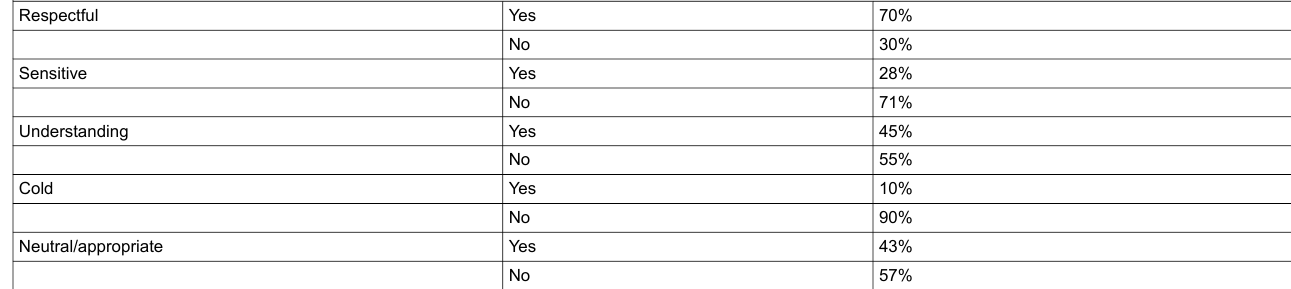
Table 5: Respondents’ perception of the behaviour of the officials participating in the forensic investigation.